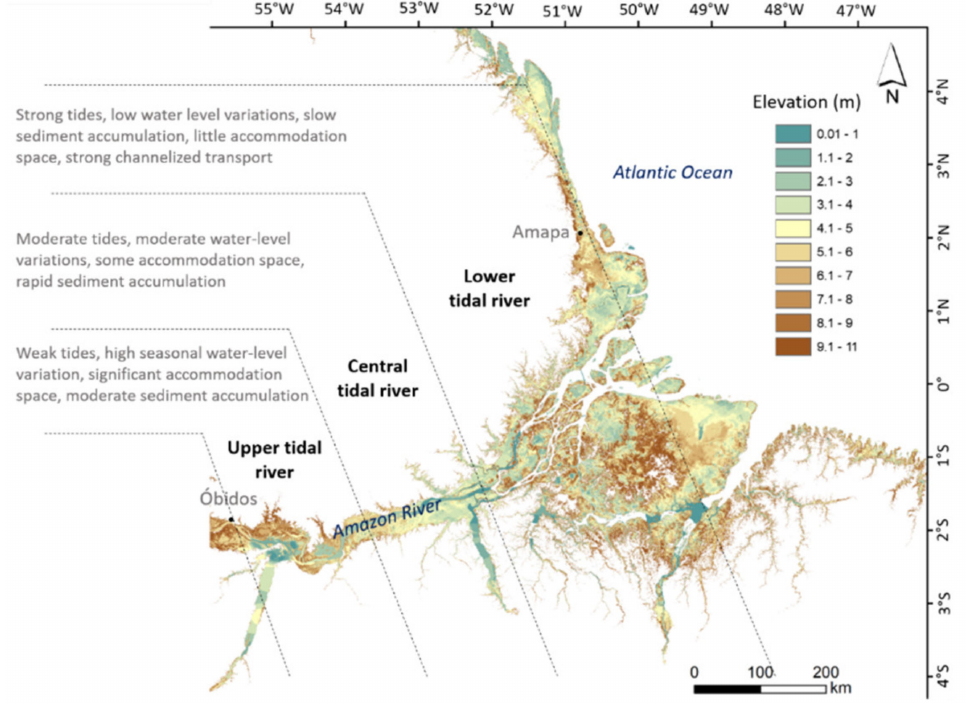
Figure 2. MERIT digital elevation model (DEM) of the Amazon delta. The MERIT DEM [39] is available for download at http://hydro.iis.u-tokyo.ac.jp/~yamadai/MERIT_DEM/, accessed on 15 February 2021. The DEM represents elevation in meters, referenced to WGS84 and EGM96. The data are prepared as 5 degree × 5 degree tiles (6000 pixel × 6000 pixel). The authors of [39] separated absolute bias, stripe noise, speckle noise, and tree height bias using multiple satellite datasets and filtering techniques. After the error removal, land areas mapped with 2 m or better vertical accuracy were increased from 39% to 58%. Significant improvements were found in flat regions where height errors larger than topography variability, and landscapes such as river networks and hill-valley structures became clearly represented. The DEM also shows the continuum of changing water levels from Ó bidos to the northern part of the river mouth and aspects of sedimentation in this continuum identified by